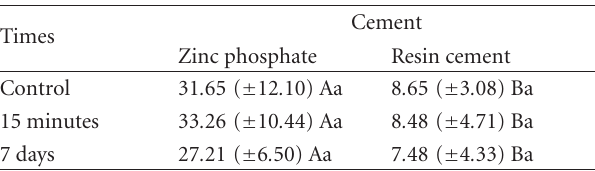
Table 2: Tensile strength means in Kgf (standard deviations) be- tween the groups and study